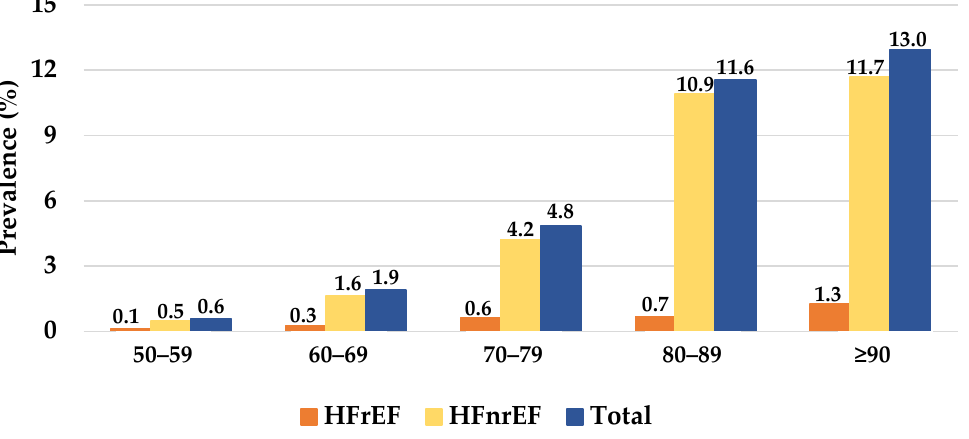
Figure 1. The prevalence of heart failure in females per heart failure subtype and age group. HFrEF, heart failure with a reduced ejection fraction; HFnrEF, heart failure with a non-reduced ejection fraction.